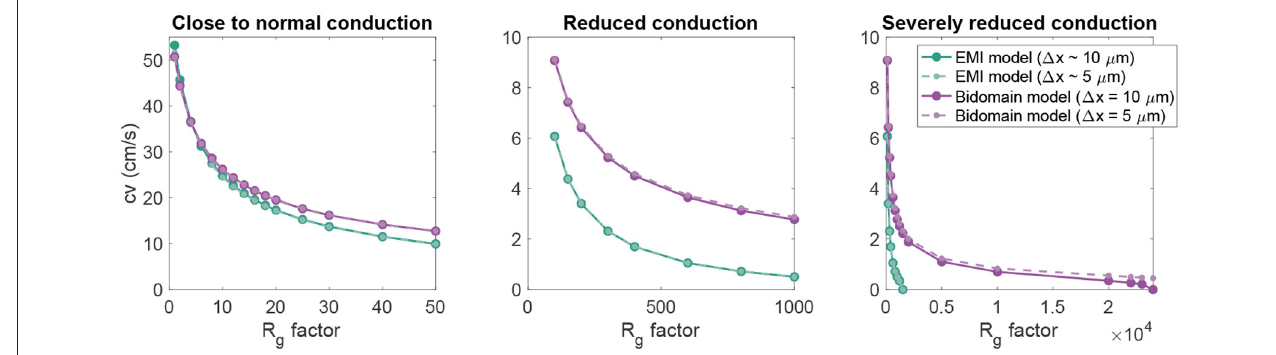
FIGURE 4 | Conduction velocity as R g is increased in EMI model and bidomain model simulations of a strand of 20 connected cells with an active membrane model (Jæger et al., 2021b). The values on the x -axis represent the factor with which the default R g value in Table 1 is multiplied. The remaining parameter values are as specified in Table 1 . Note that the plot is separated into three panels in order to improve the visibility of the data. Note also that we consider two different discretization resolutions in the simulations of each model. In the default case, 1 t = 0.001 ms and 1 x in the bidomain model and the typical edge length in the EMI model is 10 µ m, whereas in the refined case (dashed lines), both the spatial and temporal discretization steps are reduced to half of the default values.